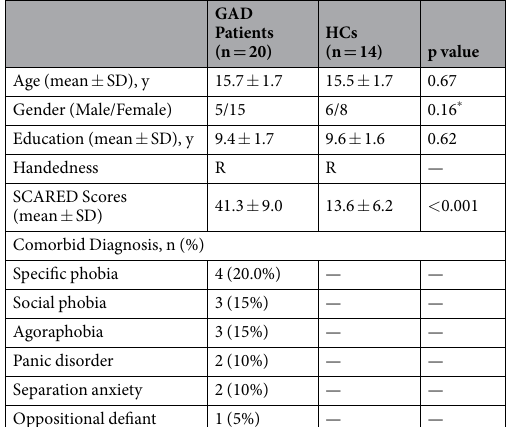
— — Table 1. Demographic and diagnostic data. Note: GAD = generalized anxiety disorder, HCs = healthy controls, SD = standard deviation, y = years, SCARED = Screen for Child Anxiety Related Emotional Disorders, R = right. The p values were obtained using two-tailed two sample test or * Pearson Chi-Square